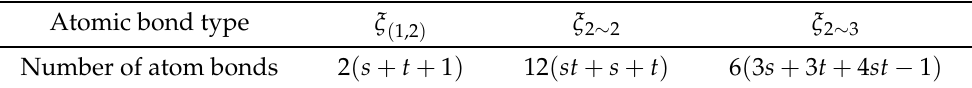
Table 1. Edge division based on vertices in the layer structure of subdivision H 3 BO 3 ( s , t )